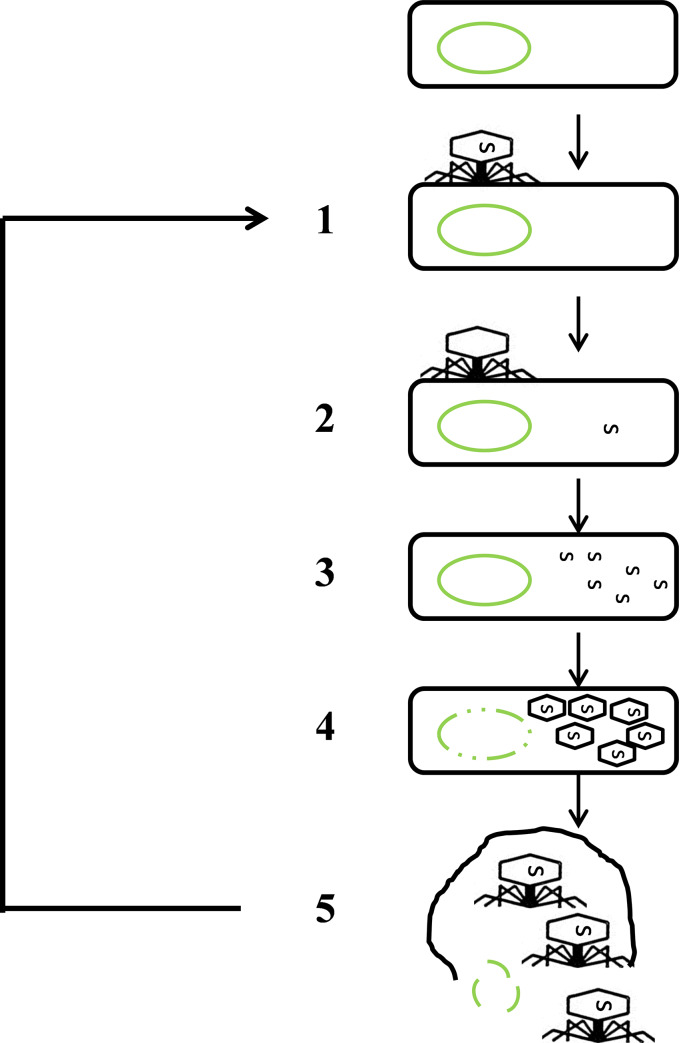
Life cycle of lytic T7 phages.Step 1, attachment of T7 phage on host; step 2, phage DNA injection into bacterial host; step 3, phage hijack bacteria metabolism and multiplication of phage DNA; step 4, production of new capsids and assembly of phages; step 5, host cell lysis and eDNA release.